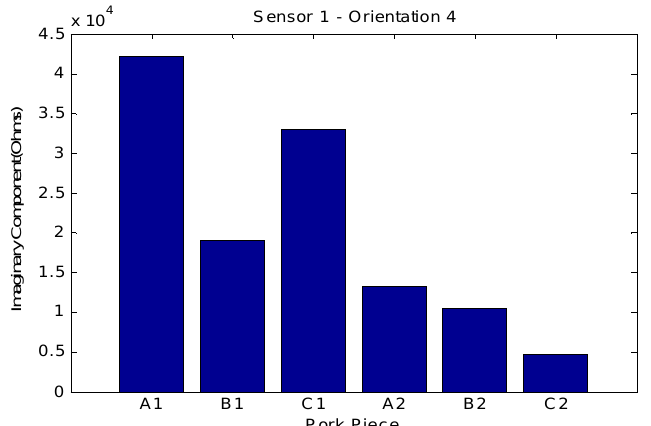
Figure 43. Sensor 1 characteristics at 5 kHz for pork belly samples at orientation 4.